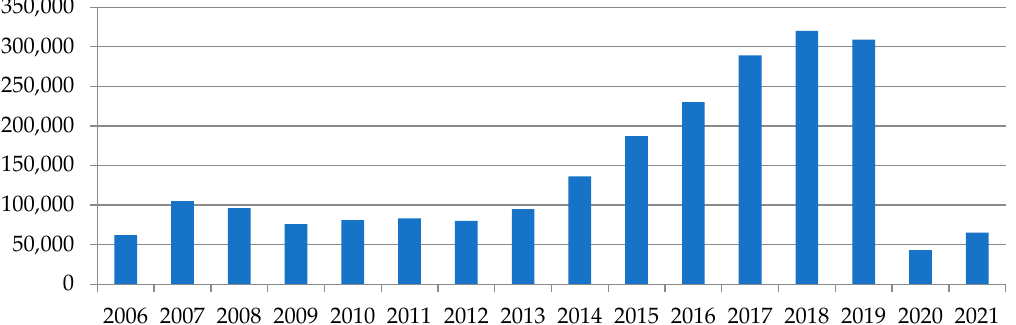
Figure 7. Evolution of arrivals in Romania of tourists from Israel (2006–2021). Source: National Institute of Statistics.